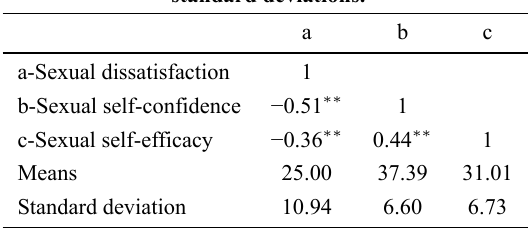
Table 1. Pearson correlations coefficients, means, and standard deviations.